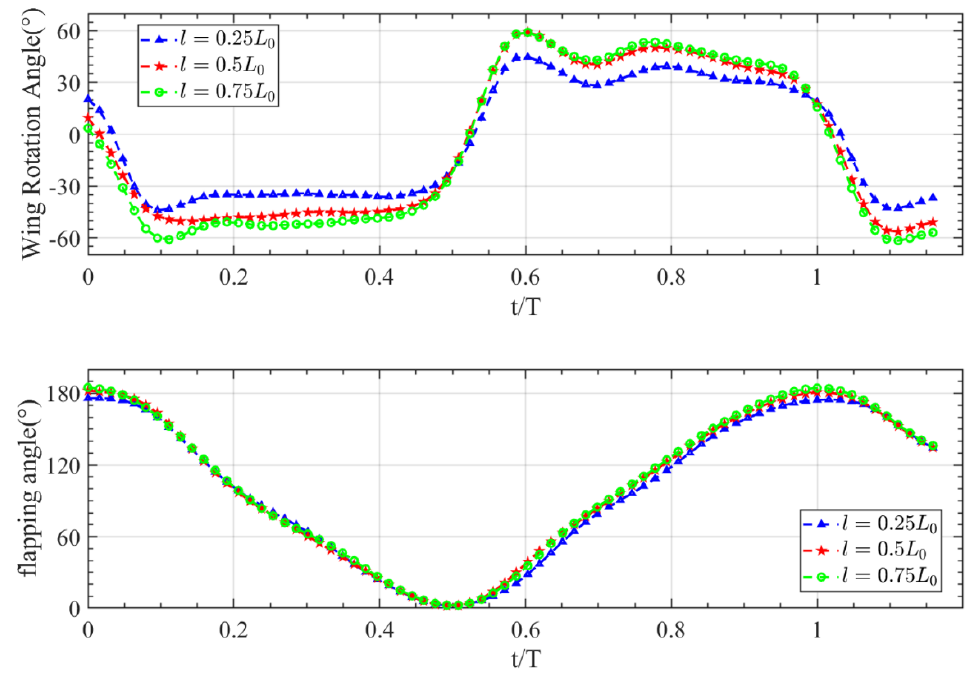
Figure 14. The wing rotation and flapping angle in one flapping cycle. Three curves indicate the angles at different positions of the leading edge.